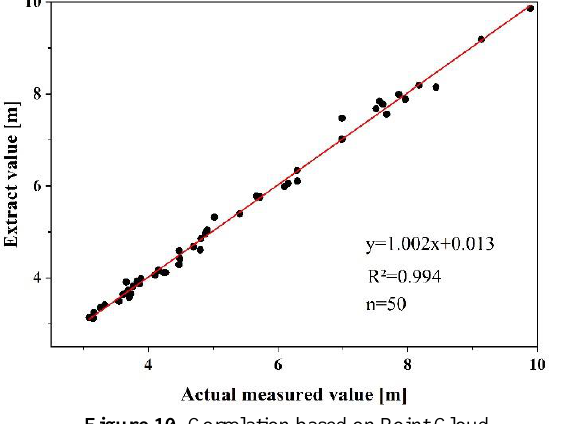
Figure 8 . Correlation based on CHM.